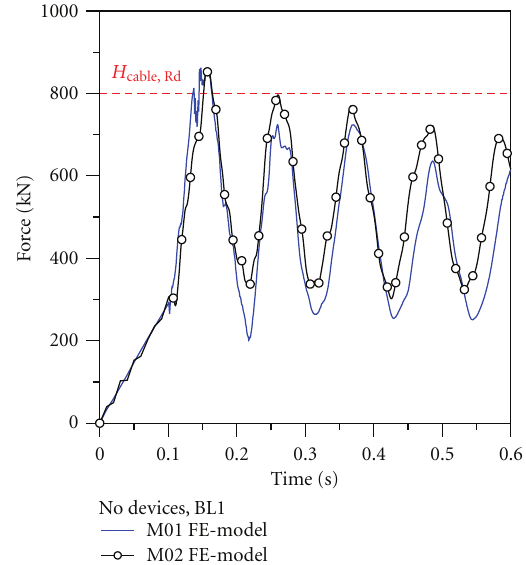
Figure 13: Comparison of axial force in the cables, as a function of time (ABAQUS). No devices. M01 and M02 FE-models, BL1.